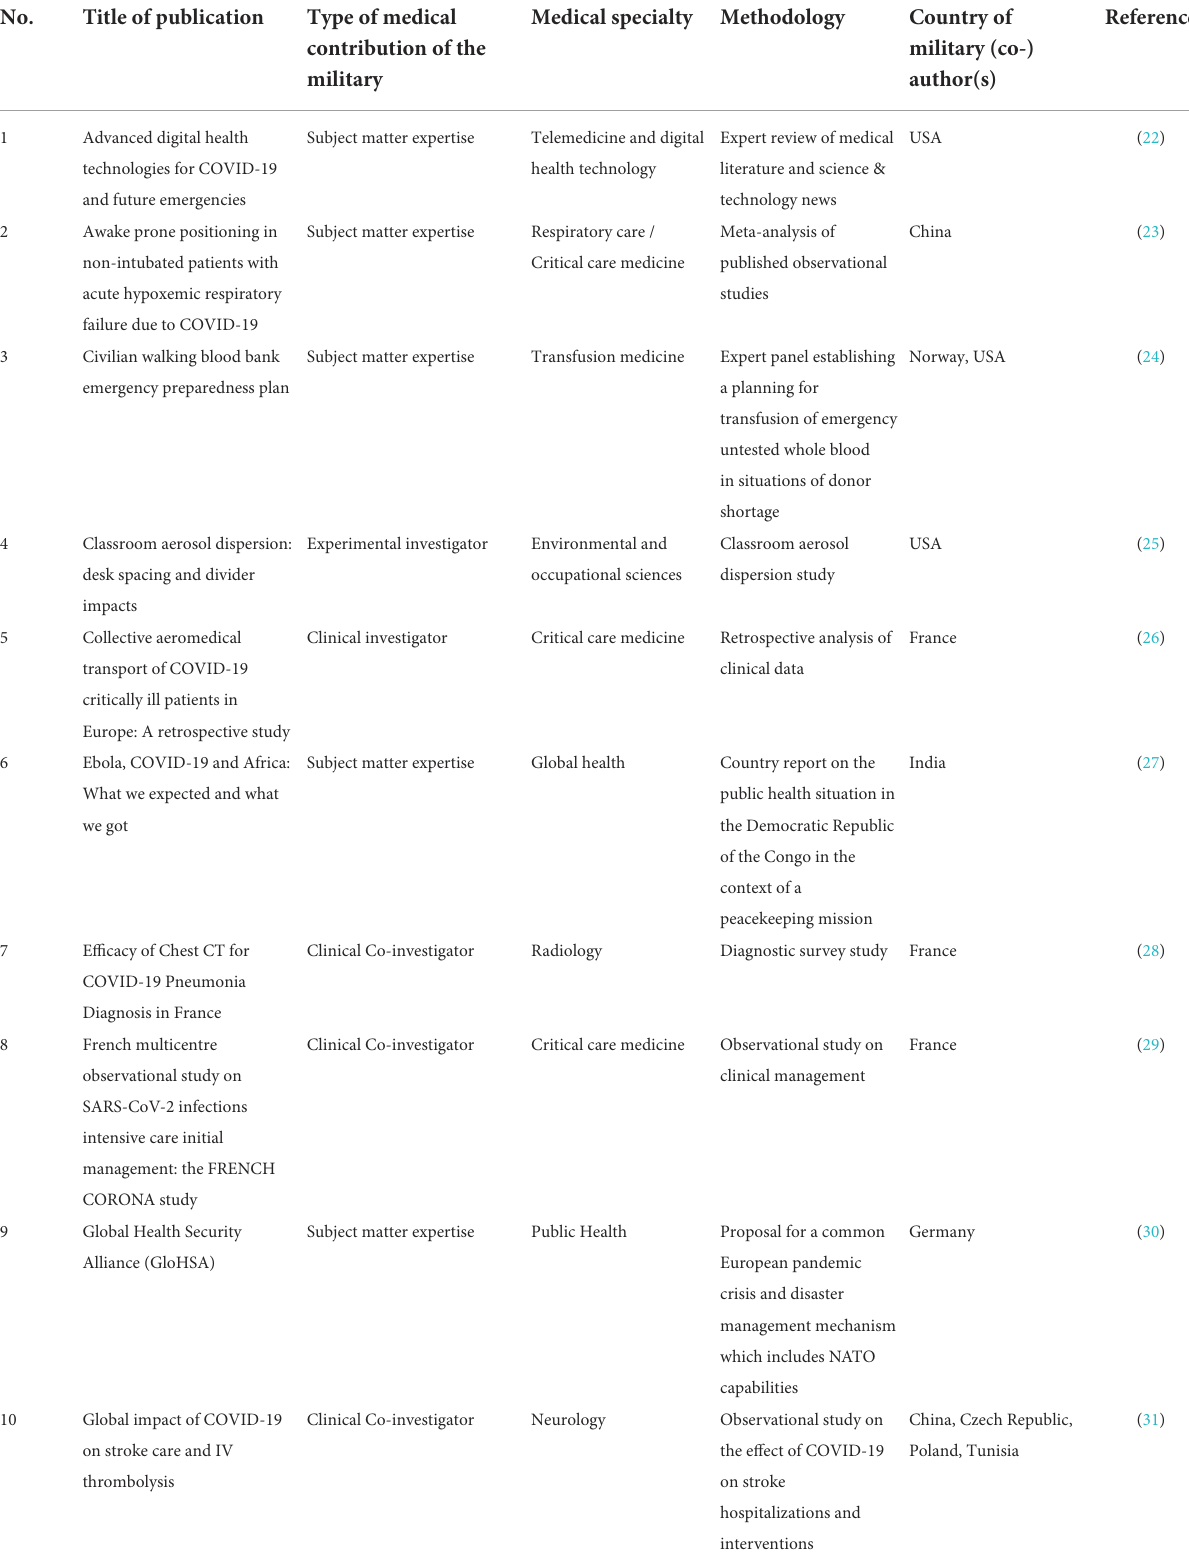
TABLE 2 Synopsis of medical publications that included the participation of military medical personal or institutions.